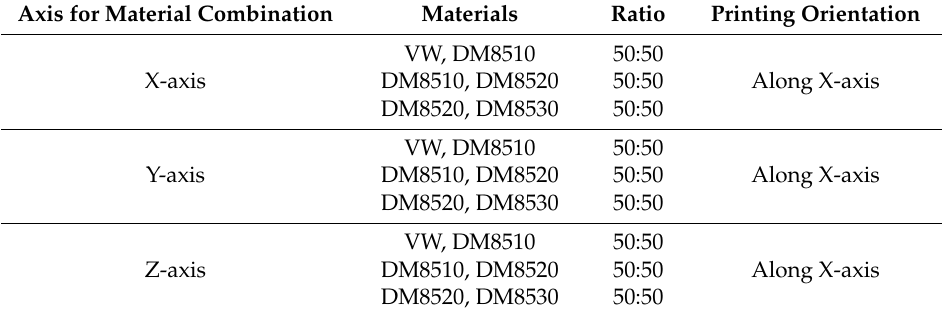
Table 1. Material information.